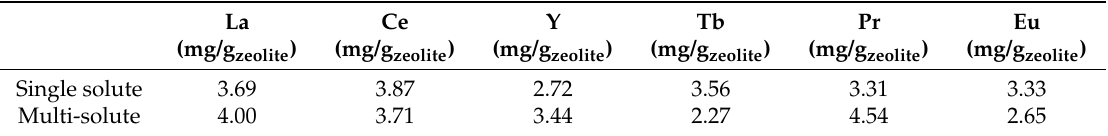
Table 2. Uptake values for the multi-component solution and for single-component solutions, in mg/g of